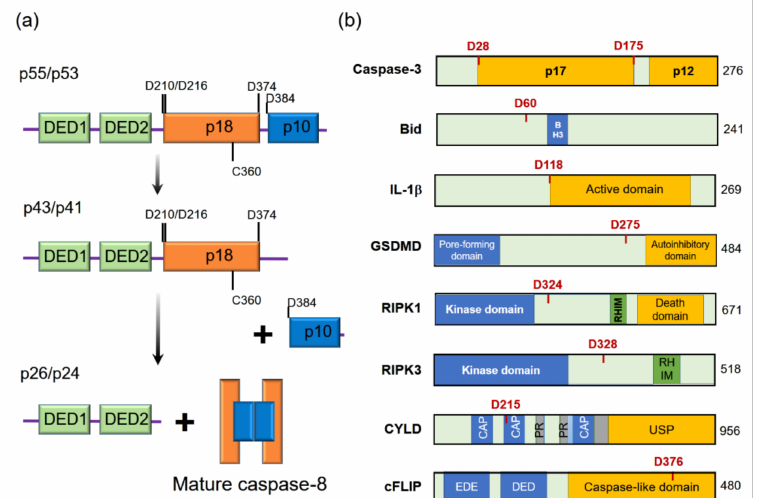
Figure 1. ( a ) Schematic showing the important residues involved in activation of human caspase-8. Procaspase-8 (p55/p53) is an inactive precursor composed of two death effector domains (DEDs), a large subunit (p18) and a small subunit (p10). The maturation of caspase-8 is derived by its auto-processing between p18 and p10 and subsequently between p18 and the pro-domain [3,4]. The mature caspase-8 consists of two large subunits and two small subunits. ( b ) Substrates of caspase-8 and targeted cleavage sites. Caspase-8 is involved in inflammation processes in a variety of ways: immune silent apoptosis induction through the cleavage of caspase-3 and bid [6–8]; inflammation induction by processing IL-1 β and gasdermin D (GSDMD) [9,10]; inhibition of inflammatory